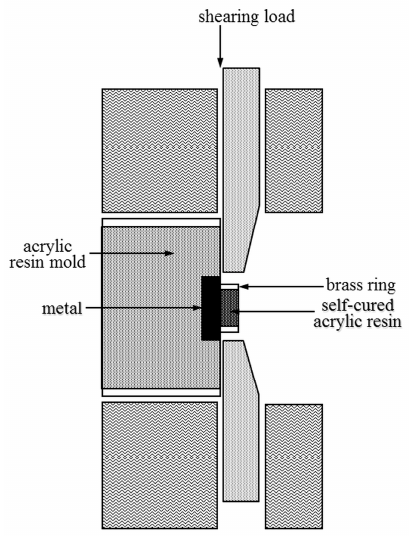
Figure 2. Shear test configuration.